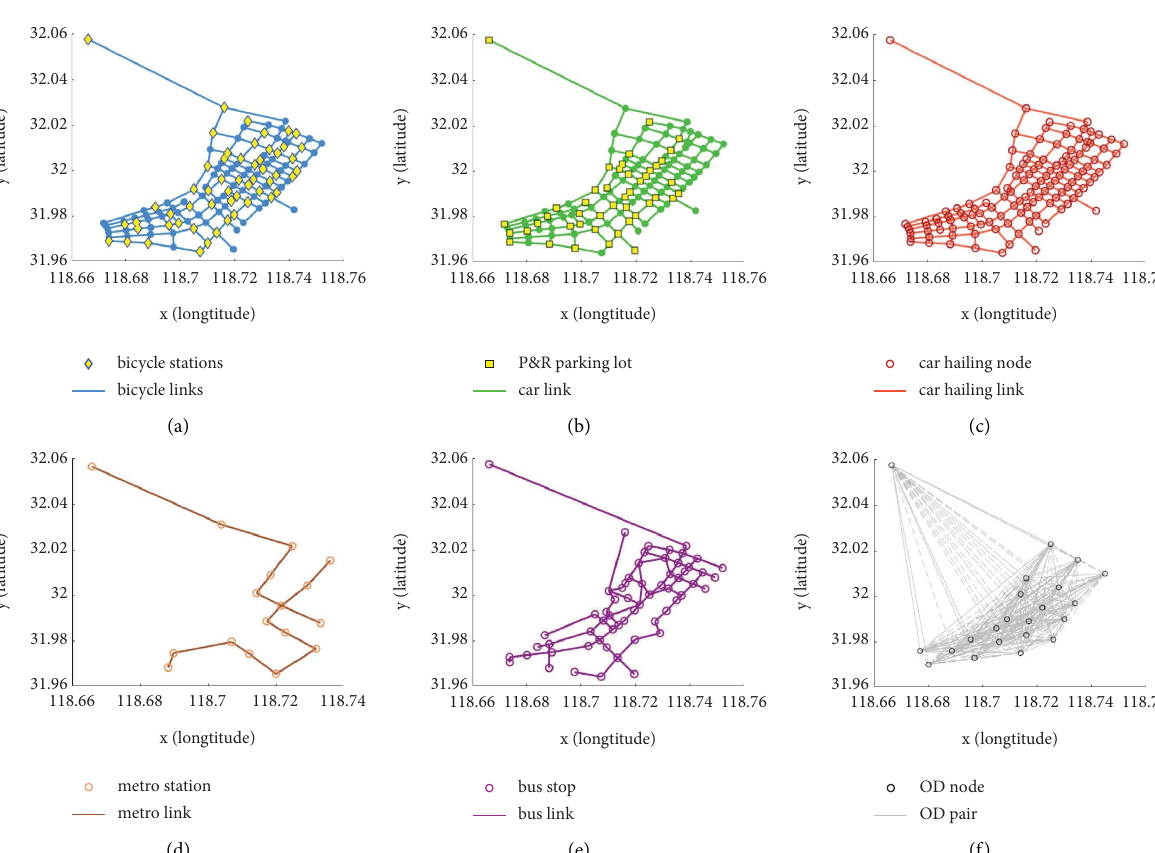
Figure 12: Original subnetworks. (a) Bicycle subnetwork. (b) Car subnetwork. (c) Car hailing subnetwork. (d) Metro subnetwork. (e) Bus subnetwork. (f) OD pair.